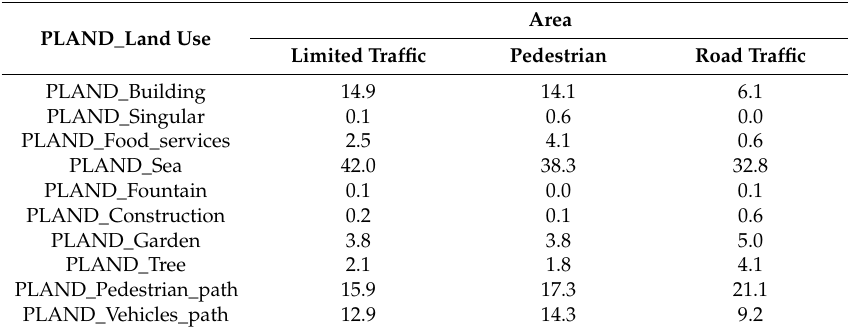
Table 3. Mean values of the spatial metric percentage of landscape (PLAND) of all the land uses in the three types of area.